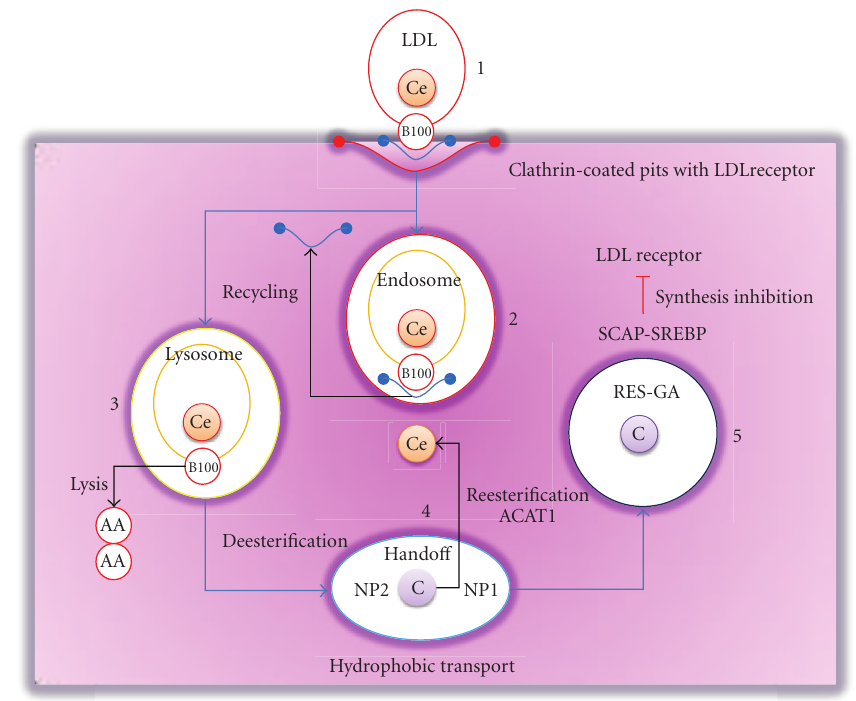
Figure 1: Regulation of LDL-R in 5 steps. Step 1. The LDL is recognized in apo-B100 by the LDL-R located in the membrane structures “clathrin-coated pits.” Step 2. It forms an endocytic vesicle or endosome containing LDL and LDL-R, the LDL-R is dissociated through lowering of the pH within the endosome, and the LDL is transferred to the lysosomes. Step 3. In lysosomes, apo-B100 is hydrolyzed into amino acids and cholesteryl ester is deesterified by enzymatic hydrolysis. Step 4. Nonesterified cholesterol (hydrophobic) is transported to the cell membranes by the “hydrophobic hando ff mechanism”; in this mechanism Niemann Pick 2 and 1 proteins form a hydrophobic core containing nonesterified cholesterol. Step 5. Nonesterified cholesterol is transferred by the binomial NP2-NP1 to cell membranes, its concentration in the Sarcoplasmic Reticulum/Golgi Apparatus membranes is the signal that inhibits the dissociation of SCAP-SREBP and thus blocks the synthesis of